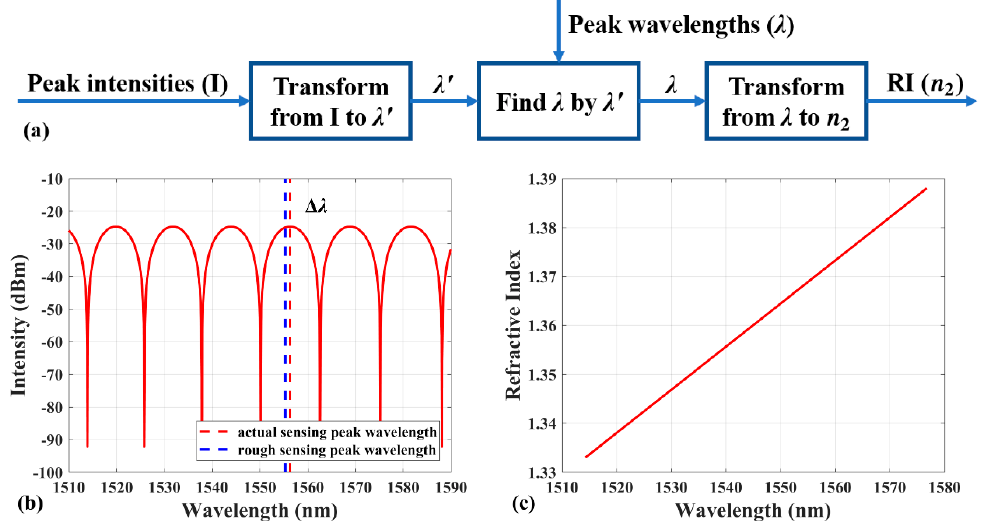
Figure 3. ( a ) Block flow diagram of the total demodulation process. ( b ) The schematic diagram of finding actual sensing peak by the rough sensing peak. ( c ) The theoretical response curve of EFPI RI sensor.